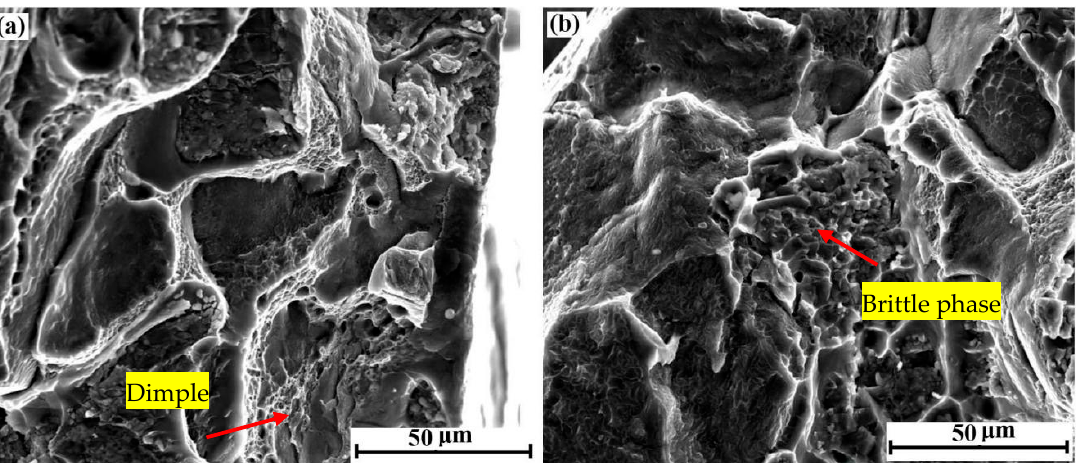
Figure 5. Tensile fracture morphology of 7085 specimen in atmosphere: ( a ) The edge area of fracture and ( b ) The heart area of fracture.